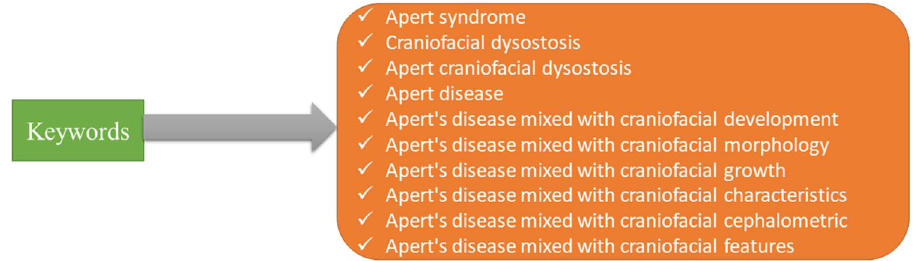
Figure 1. Keywords used in search